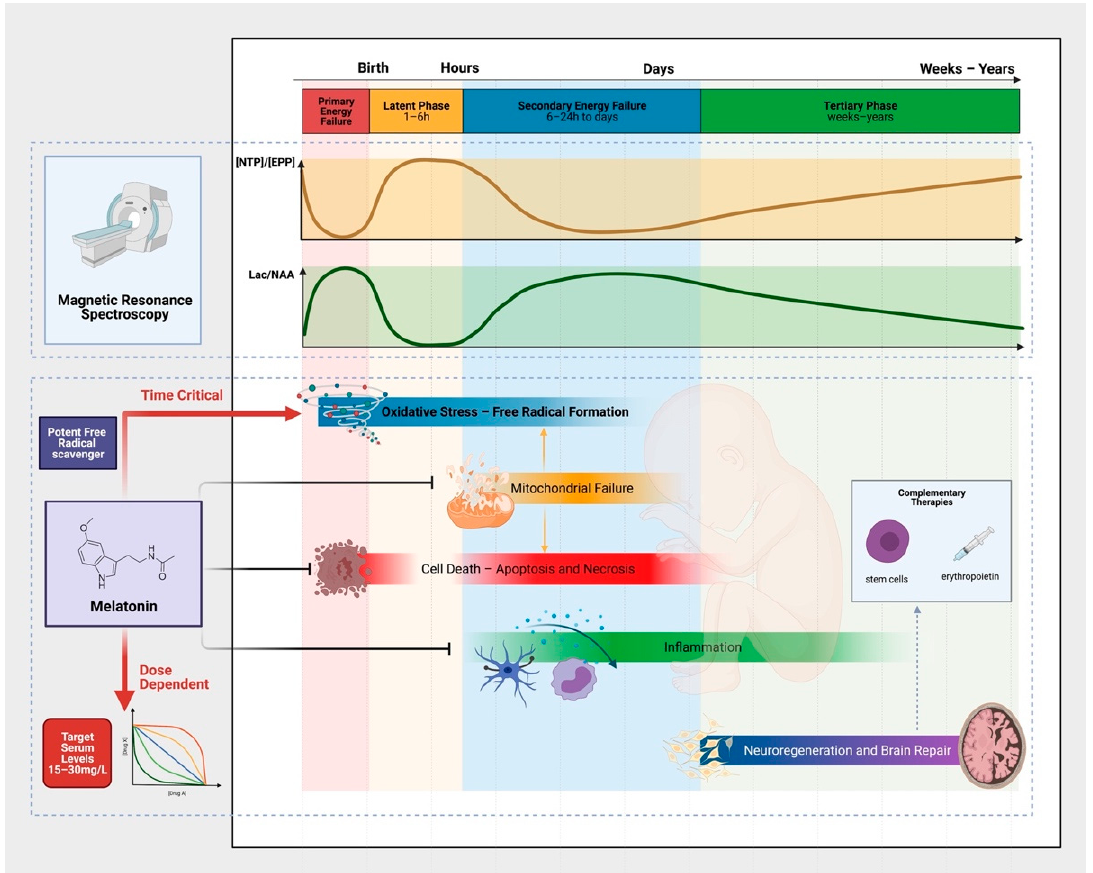
Figure 1. The Evolution of Brain Injury, Pathophysiology and the Neuroprotective Action of Melatonin. Characteristic phases (primary, latent, secondary and tertiary) of brain injury occurs following hypoxia-ischemia. These phases can be measured using proton ( 1 H) and phosphorus magnetic resonance spectroscopy. After the primary insult and a period of recovery in the latent phase, secondary energy failure occurs (characterised by a secondary rise in Lactate to N-acetyl aspartate (Lac/NAA) peak ratio on 1 H MRS) in parallel with the neurotoxic cascades of cellular injury. The pathological processes are multifactorial—including oxidative stress, activation of cell death pathways, neuro-inflammation, and mitochondrial failure. The neuroprotective action of melatonin is diverse. To harness its strong antioxidant properties, supra-physiological melatonin levels (15–30 mg/L) are needed early in the neurotoxic cascade. Complementary therapies including stem cells and erythropoietin targeting the tertiary phase of injury may further improve outcomes in combination with melatonin for infants with NE.